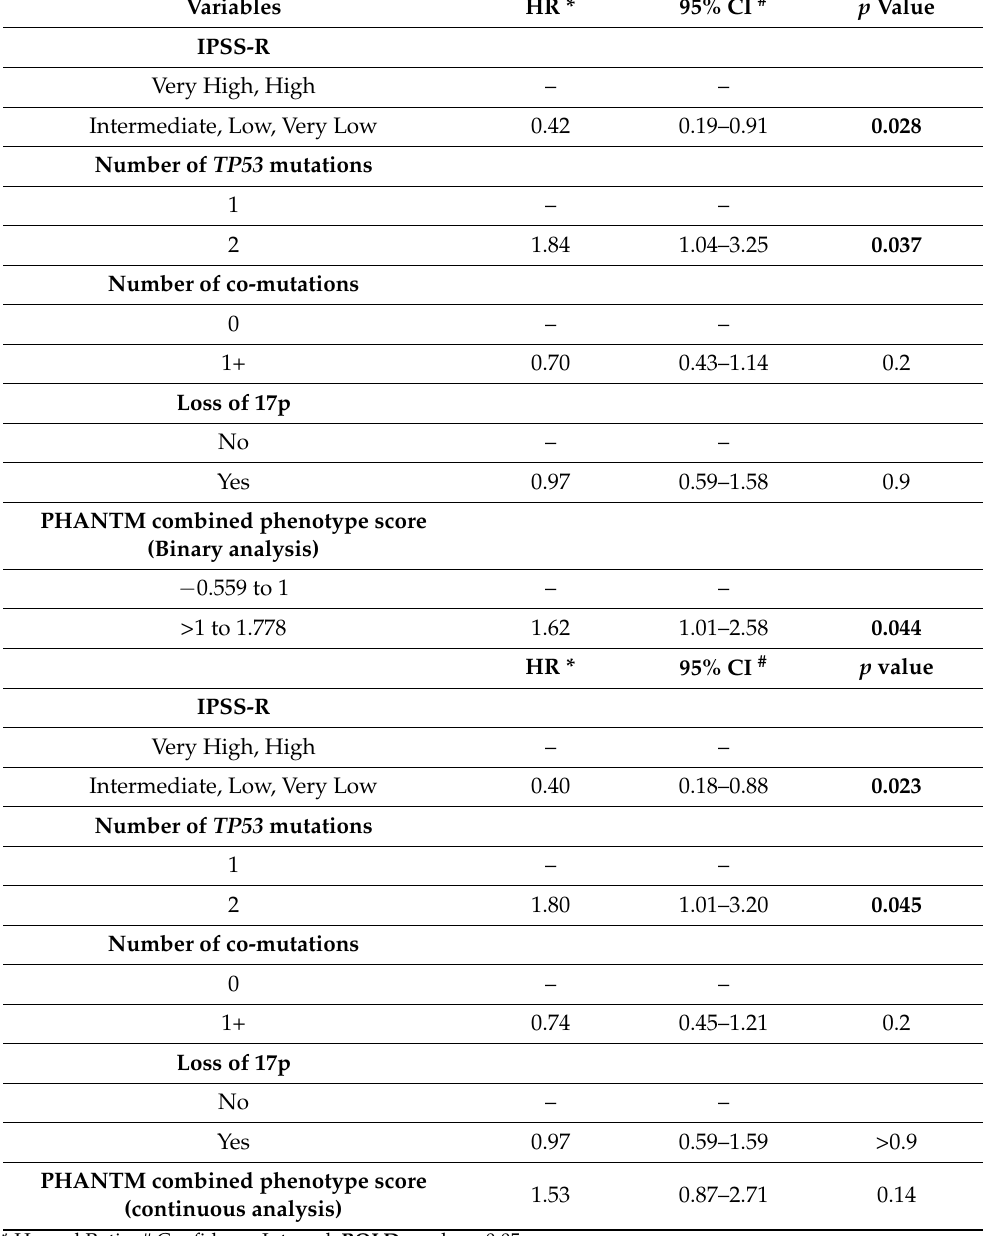
Table 4. Multivariate analysis for association with